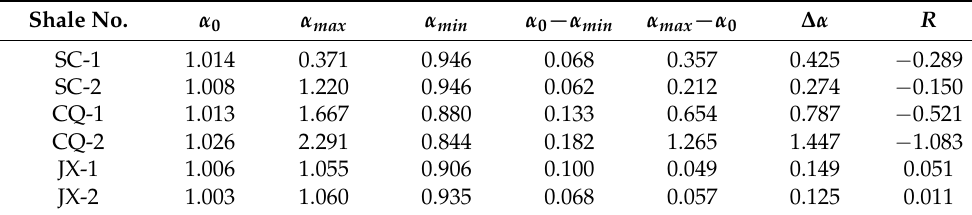
Table 4. Characteristic parameters from generalized fractal spectra of inorganic shale pores. Shale No.